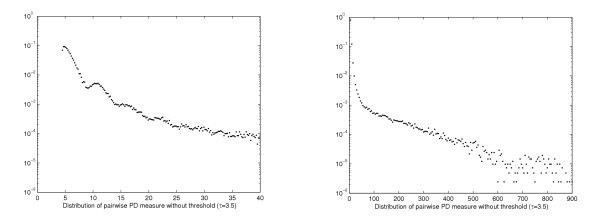
Distribution of pvalue-distances between feature vectors Ppvalue with thresholding (τ= 3.5). Thresholding introduces complex effect on the distribution of the PD measure and makes the derivation of its significance level difficult. Right: The complete distribution is plotted in logscale. The linear correlation in logscale suggests an exponential decay. Left: Zoom-in on the range [0,40]. The distribution is multi-modal due to the contributions of a different number of elements to sum as in Equation (4). The smallest nonzero PD measures start at approximately 4.426, which corresponds to a match of two feature vectors Ppvalue at one entry where the z-score is equal to 3.5, i.e. a pvalue of 0.0120 or -log pvalue = 4.426. The distribution decreases rapidly and increases again at PD ≈ 9, corresponding to a match of two feature vectors at two distinct entries with zscore ≈ 3.5. The pattern repeats periodically as the number of significant entries common to both feature vectors increases.